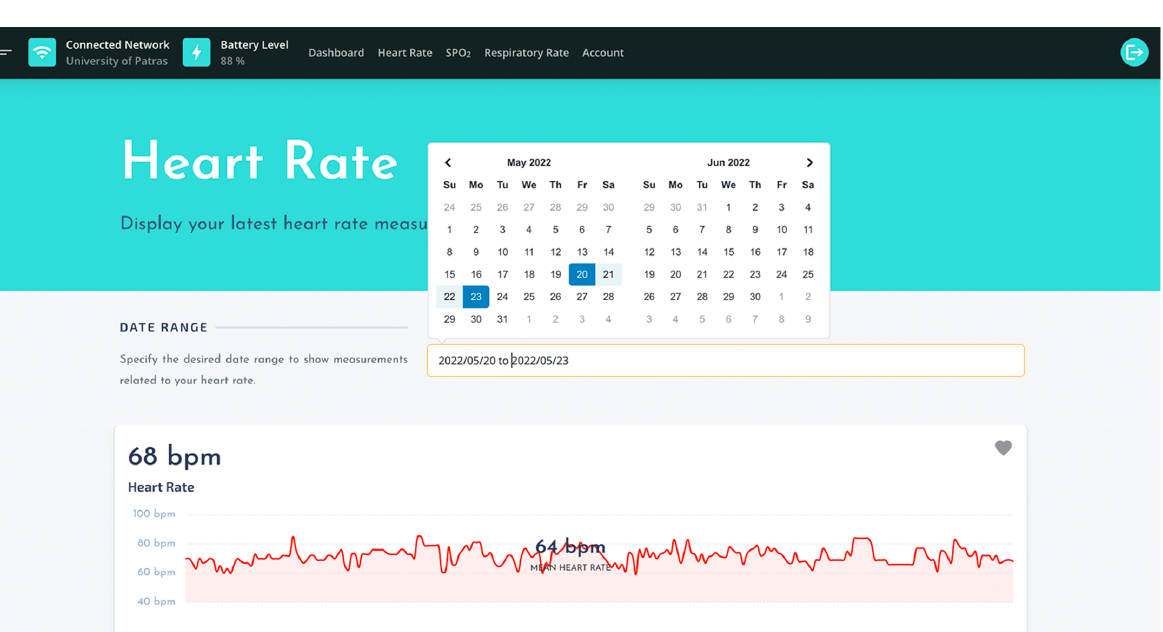
Figure 13. The UI of user account page. 4.2. Back-End Implementation Back-end stands for the server side of a web-based application. On the back-end side, the web-based application implements embedded PHP scripts within the front-end code to provide dynamic functionalities. The dynamic aspect of the web-based application en- ables the capability to retrieve and visualize data from the database in a near real-time manner. The back-end comprises a RESTful API that allows submission of collected data from the wearable device into the database. More specifically, it parses a JSON object with the payload’s data and decodes it to extract each value and insert it into the database. A